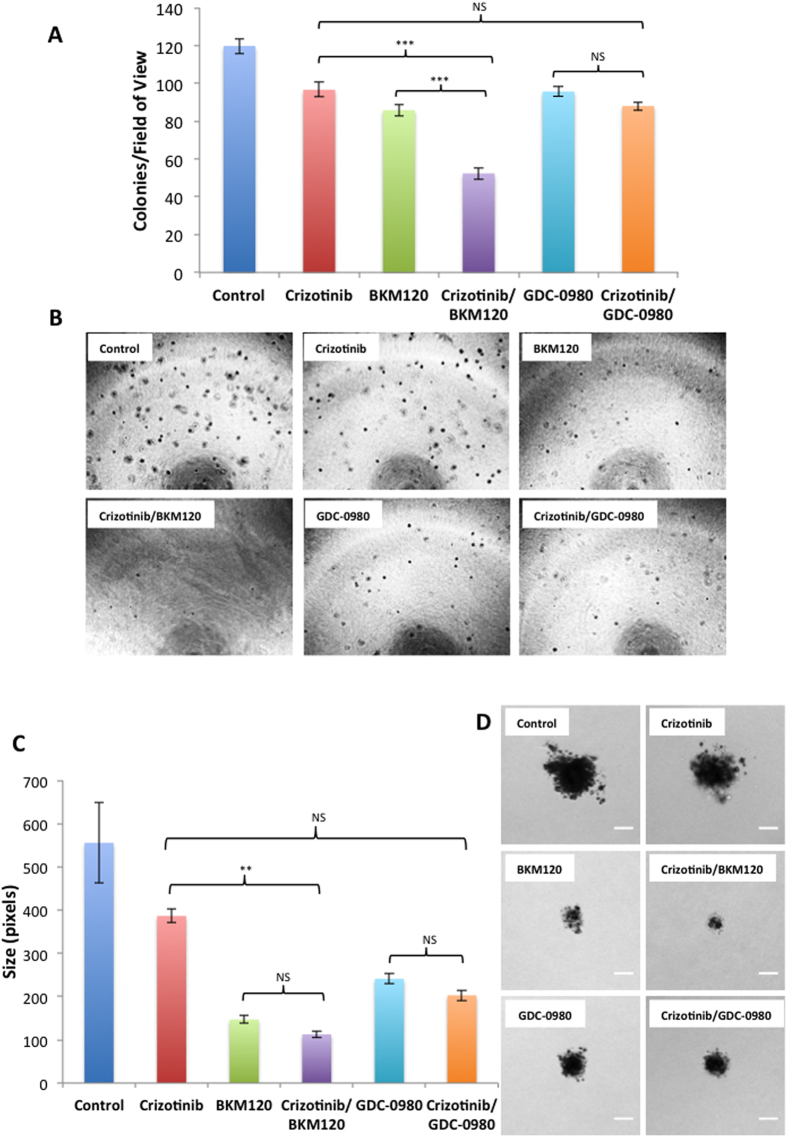
Crizotinib, BKM120 and GDC-0980 alone or in combination inhibit the anchorage independent growth of mesothelioma cells in a soft agar assay.H2596 cells were seeded in 0.4% Agarose and treated with 1 μM crizotinib, 2 μM BKM120, 0.25 μM GDC-0980 alone and in combination for a period of 30 days. Images of colonies were taken and colonies were counted using Image J. (A) Results are expressed as number of colonies per field of view ± SEM. Results were analyzed by ANOVA with Tukey post-test. (NS p > 0.05, *p < 0.05, **p < 0.01, ***p < 0.001) (BKM 120 Vs BKM120/crizotinib p < 0.001 GDC-0980 Vs GDC-0980/crizotinib p < 0.05). (B) Representative images of colonies. (C) Colony size in pixels for different groups ± SEM. (BKM120 Vs BKM120/crizotinib p < 0.01 GDC-0980 Vs GDC-0980/crizotinib p < 0.05) (D). Images of colonies were taken using a Zeiss Axiovert 200 m inverted optical microscope. Representative images of single colonies are shown at 10x magnification. Scale bar = 20 μm.